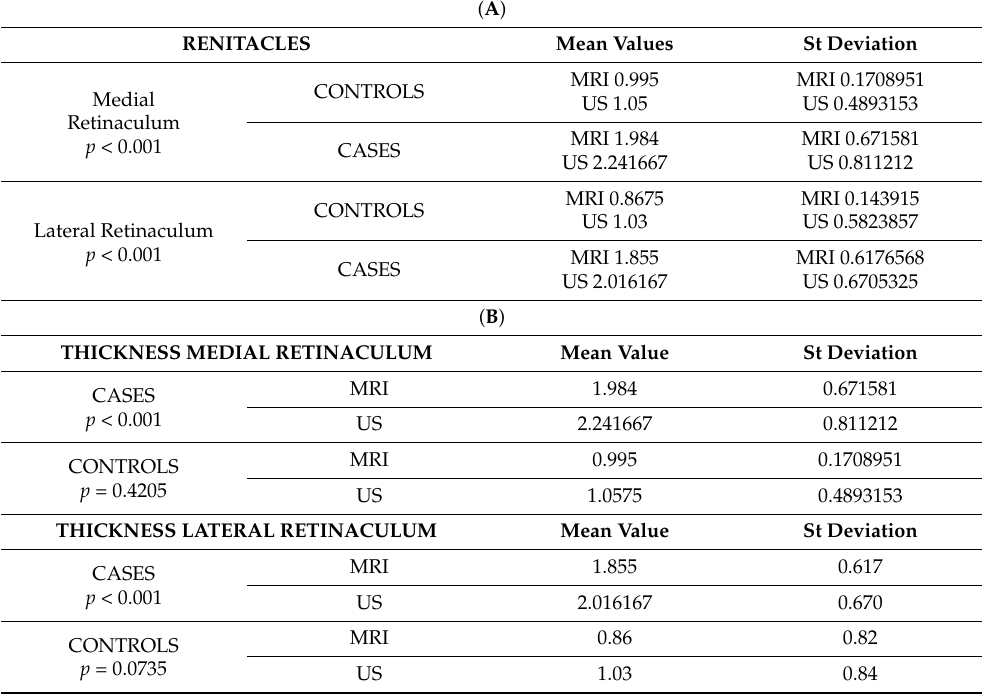
Table 2. ( A , B ) Student’s t -test. Retinacle Thickness. ( A ). Student’s t -test to differentiate the me- dia values of retinacle thickness IN CASES AND CONTROLS using MRI and US. The difference in media values of medial retinaculum thickness in cases and controls is statistically significant using the Student’s t -test in both MRI and US. MRI (Media cases = 1.98 ± 0.67 mm; e media controls = 0.99 ± 0.17 mm). US (Media cases = 2.24 ± 0.81 mm; e media controls = 1.05 ± 0.48 mm). The difference in media values of lateral retinaculum thickness in cases and controls is statistically significant using Student’s t -test in both MRI and ECO. MRI (Media cases = 1.8 ± 0.6 mm; e media controls = 0.86 ± 0.14 mm). US (Media cases = 2.01 ± 0.67 mm; e media controls = 1.03 ± 0.58 mm). ( B ). Student’s t -test to compare the media values of MRI AND US to evaluate retinacle thickness in cases and controls. Media values of retinacle thickness examined by US and MRI show statistically significant differences (Retinacles: Media MRI: 1.98 ± 0.67 mm, Media US: 2.24 ± 0.10 mm). In controls, there was no statistically significant difference.